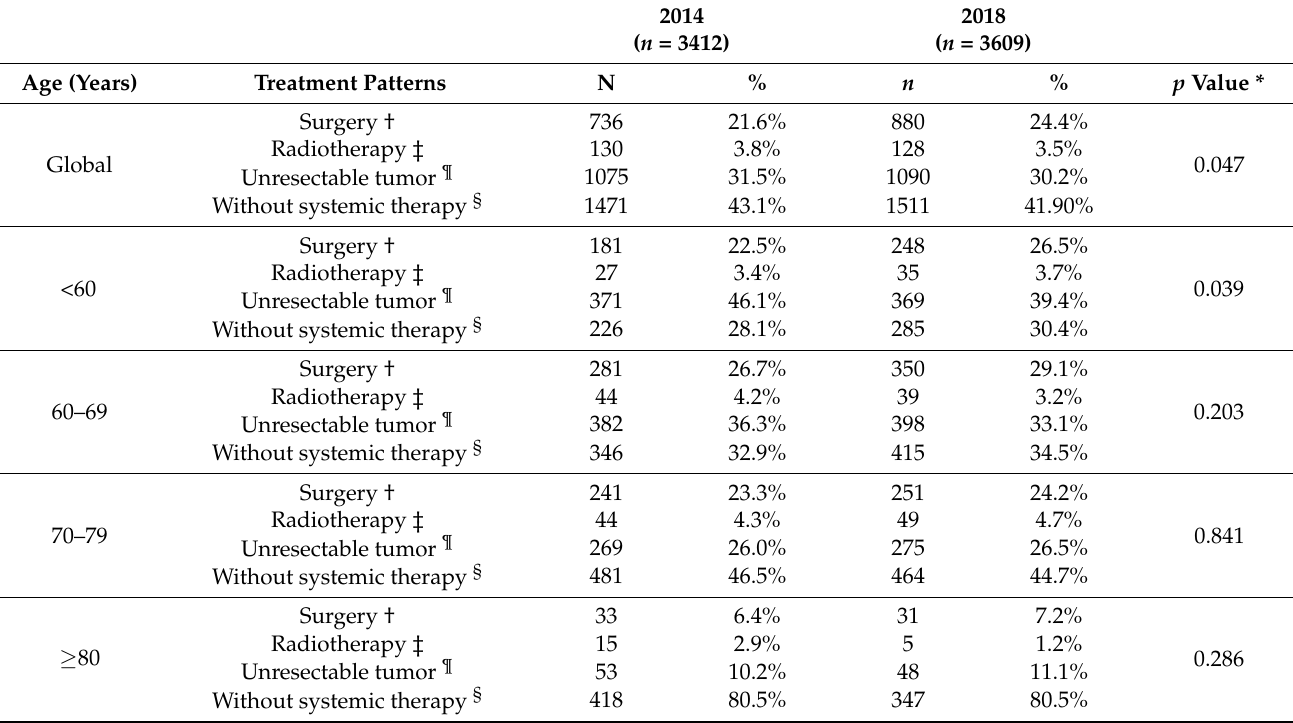
Table 2. Treatment pattern group initiated in 2014 and 2018 by age